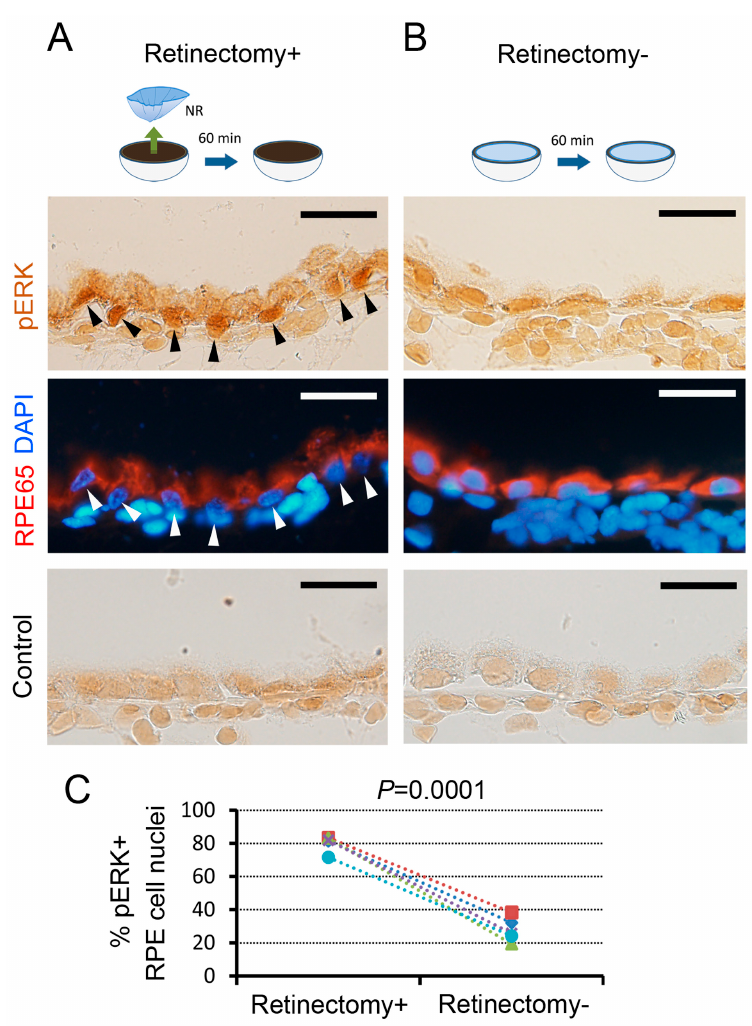
Figure 2. Effects of the neural retina (NR) on MEK-ERK signal reinforcement in RPE cells. ( A , B ) Representatives showing the effects of retinectomy on ERK activity in RPE cells (5 newts). Black and white arrowheads indicate pERK+ nuclei. Note that, for immunohistochemistry, the eye cups after 60 min incubation were fixed after removal of the NR. RPE cells were identified by RPE65 immunoreactivity (red). DAPI (blue): nuclei. To control immunoreactivity (lowermost panels), pERK antibody was replaced with a control IgG. Scale = 50 μ m; ( C ) Proportion of pERK+ RPE cell nuclei in the Center. In retinectomy+, ~80% of RPE cell nuclei showed pERK+, whereas in retinectomy- the number of pERK+ RPE cell nuclei was decreased significantly to less than 40% (Student’s t -test, p = 0.0001, 5 newts).